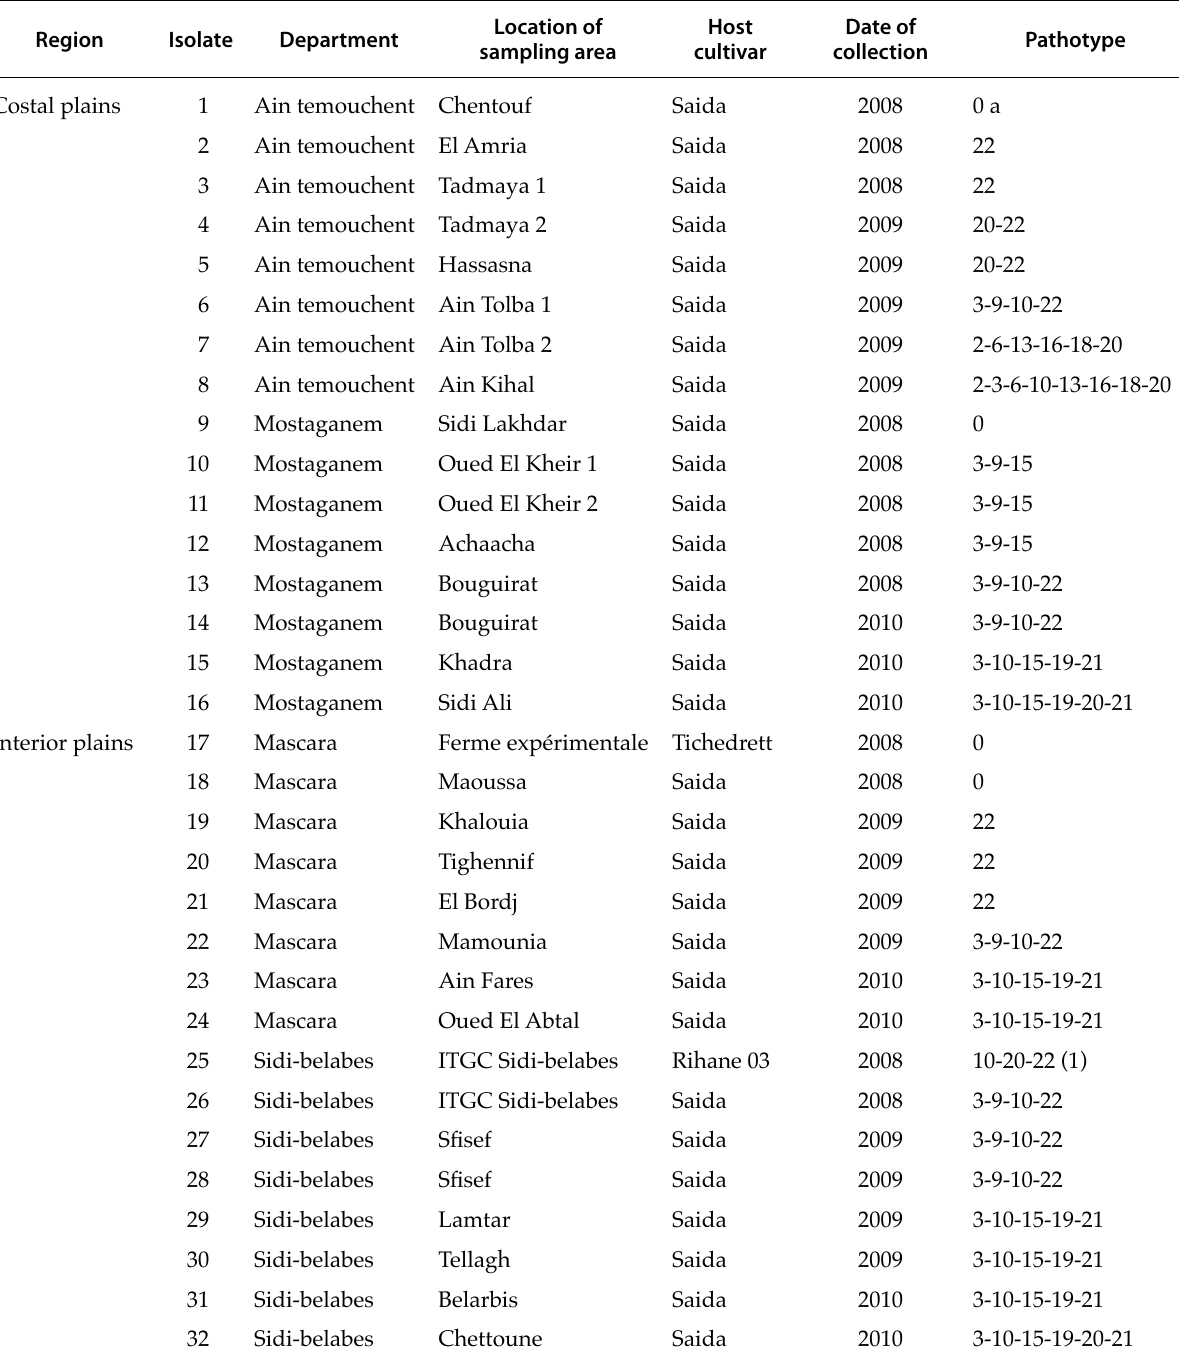
Table 1. Geographical origin and pathotypes of the Pyrenophora teres f. teres isolates obtained from diseased barley from different departments in north-western Algeria .